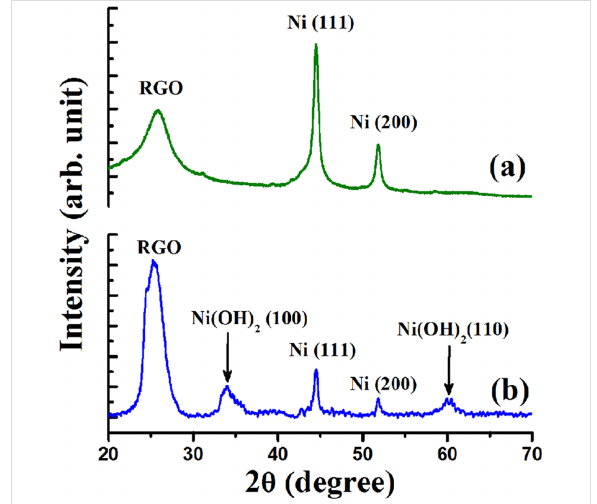
Figure 3: (a) XRD of fresh Ni/RGO-40 and (b) the recovered catalyst after the first cycle of C–S coupling.